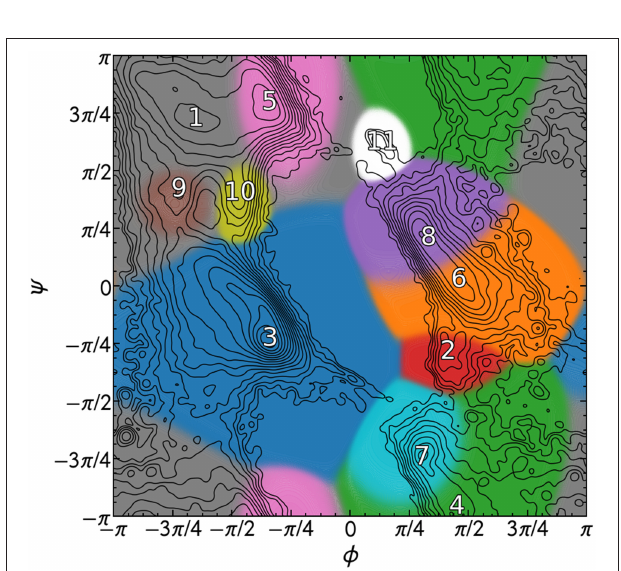
FIGURE 4 | PAMM clustering of all calculated dihedral angles with ζ = 0. Cluster numbers are placed at the mode of the cluster, and each cluster has been colored differently. The isocontours of the total distribution are equally spaced on a logarithmic